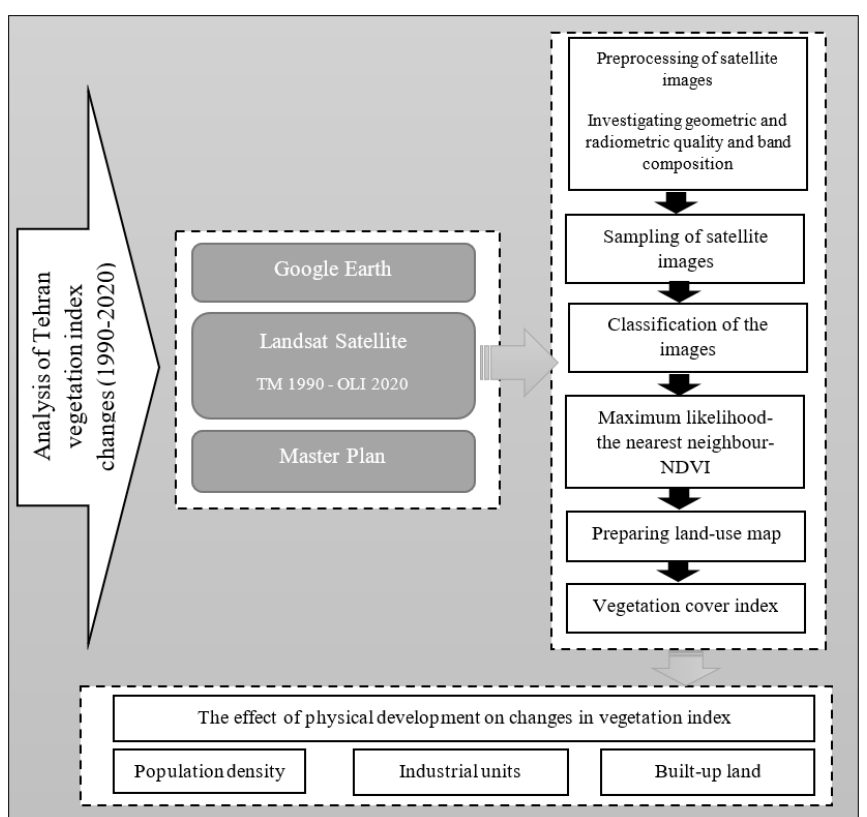
Figure 2. Data Analysis.